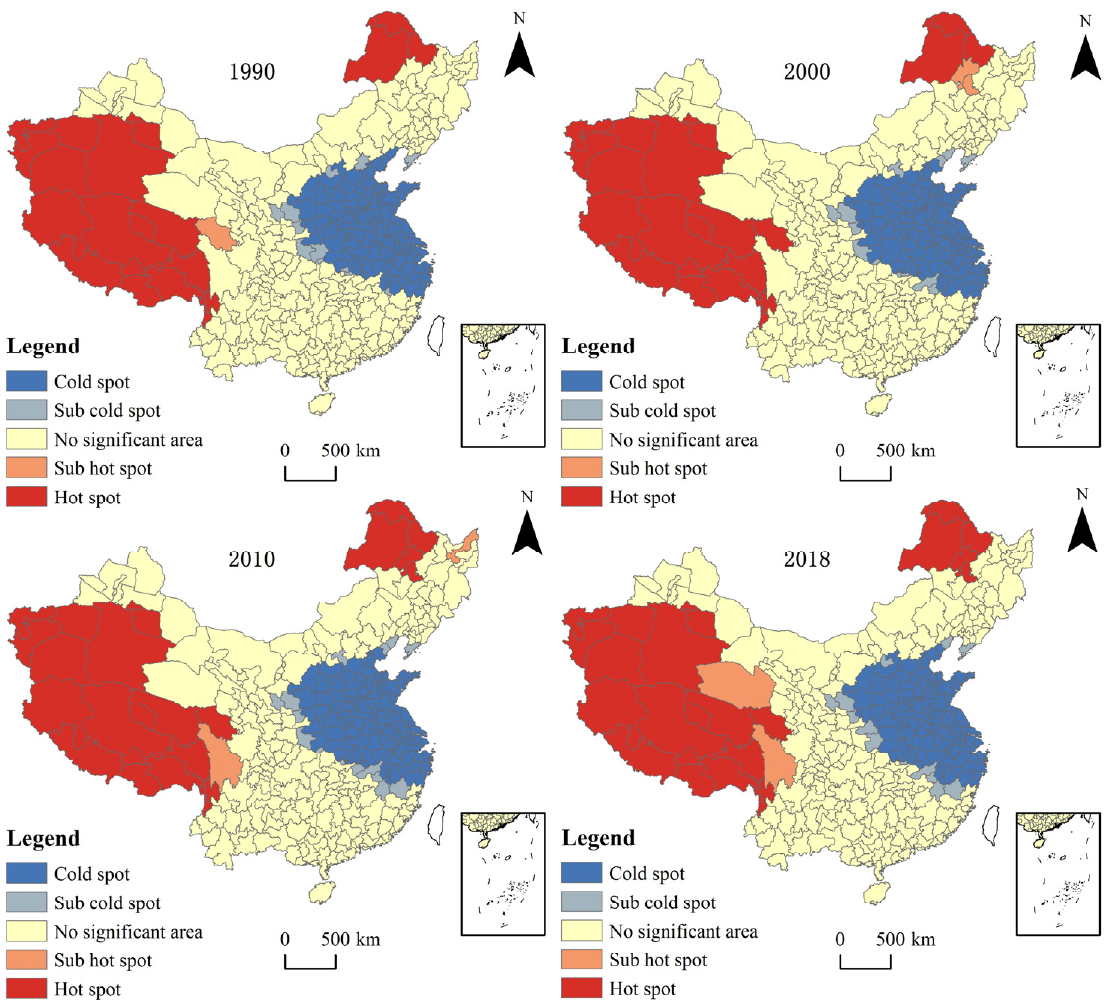
Figure 5. Spatial distribution of cold and hot spots of ESV in China from 1990 to 2018.